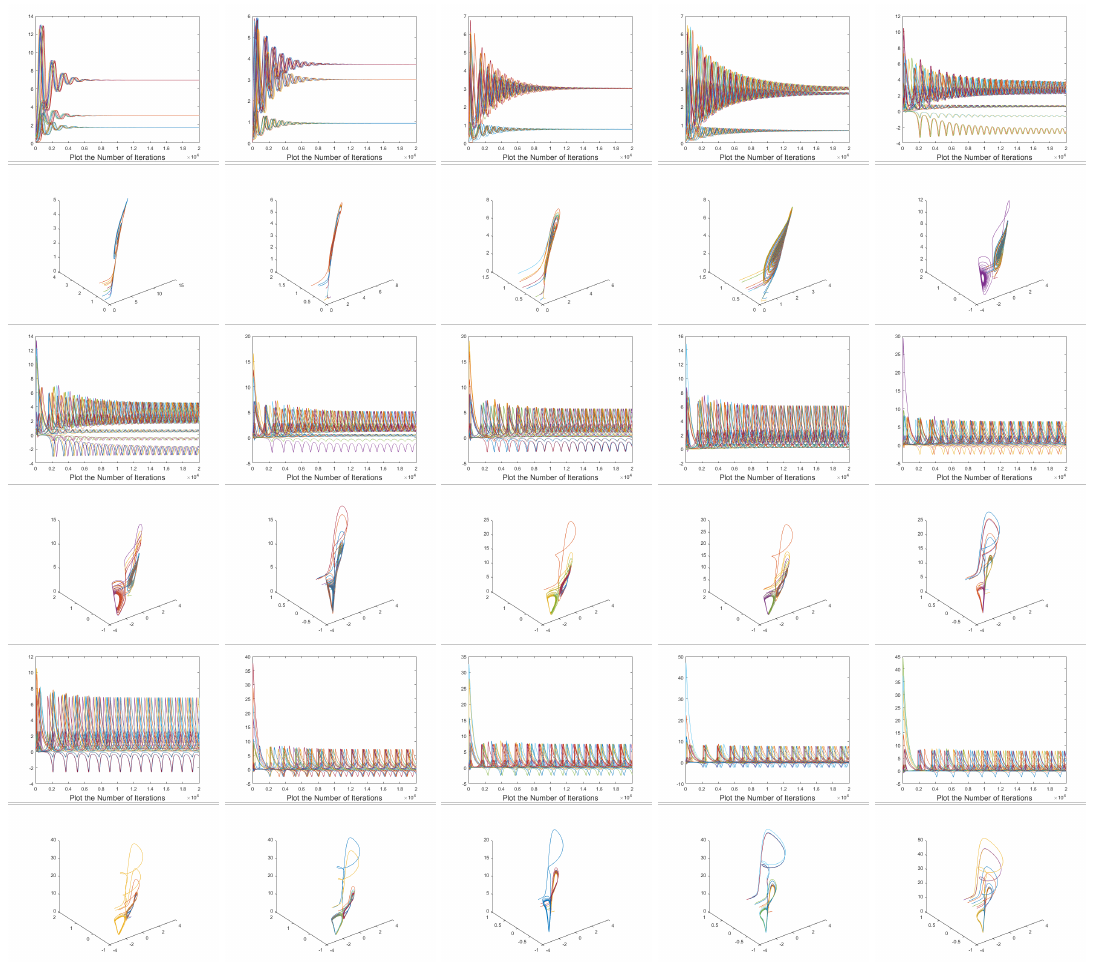
Fig. 13 Trajectories (Up) and three dimensional plots (Down) respectively for the system D 51 , 3 , 4 [ n ] where the degree of the system n varying from 1 to